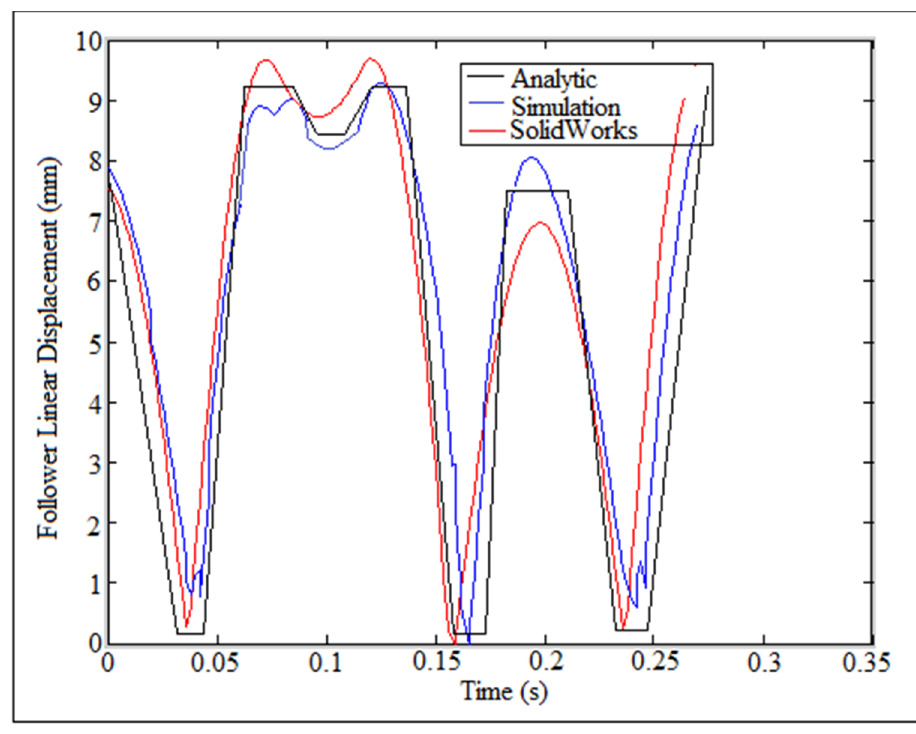
Figure 12. Comparison of follower linear displacement.